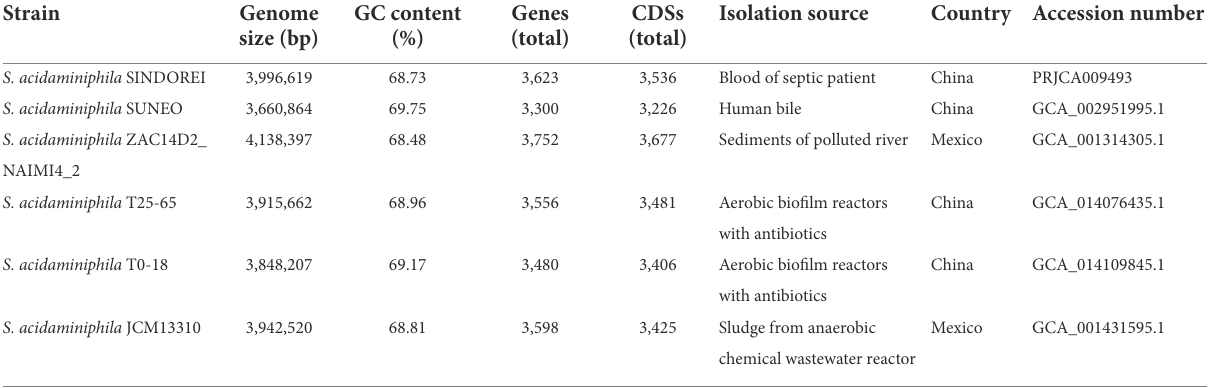
(Supplementary Table S5), Pfam (Supplementary Table S6) and Swiss-Prot (Supplementary Table S7). A total of 3,623 genes, including 3,536 coding sequences (CDSs), were predicted in the genome, along with 68 transfer RNA (tRNA genes) and nine ribosomal RNA (rRNA genes). The strain SINDOREI genome was profiled as a circular map, exhibiting CDSs, virulent genes, GC plot, and GC skew (Figure 1).